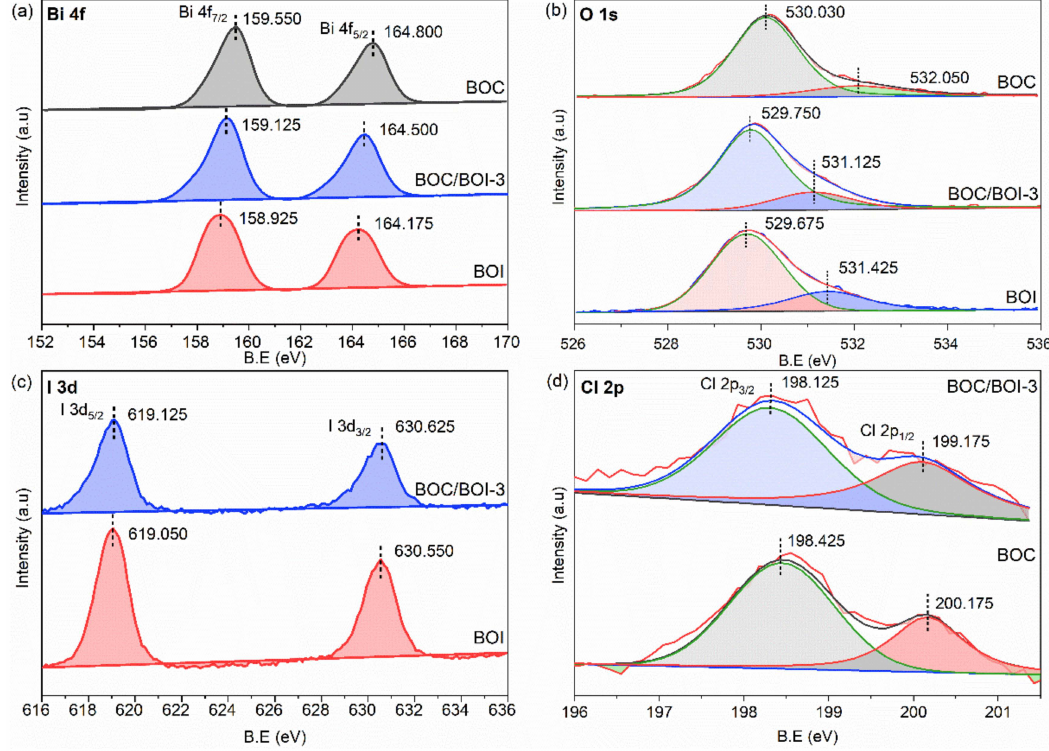
Figure 4. ( a ) High-resolution XPS core level data for Bi 4f, ( b ) O 1s, ( c ) I 3d, and ( d ) Cl 2p obtained from BOC, BOI, and BOC/BOI-3